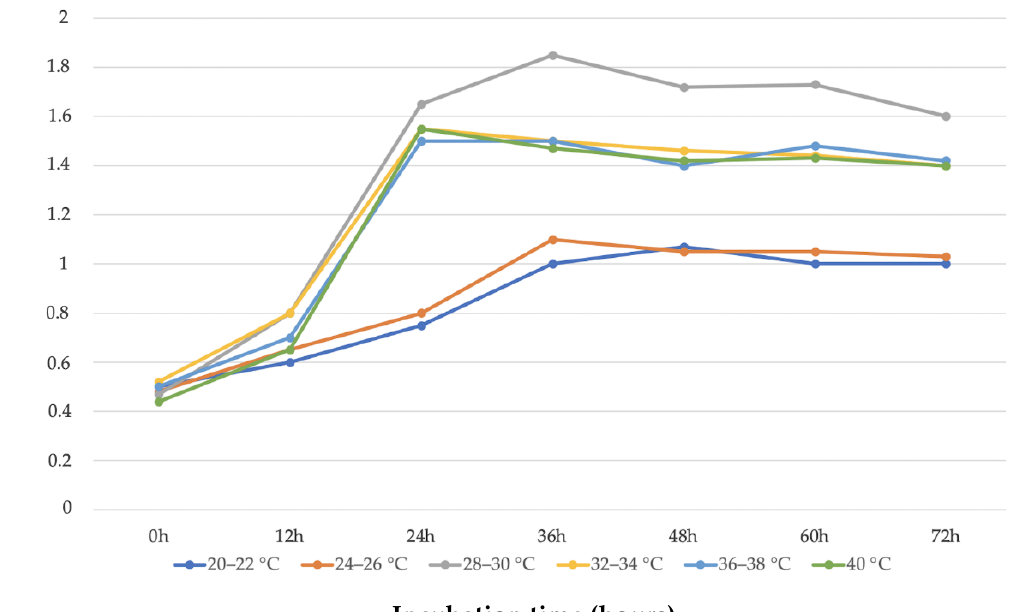
Figure 5. Strain 1B growth at different incubation temperatures and times.